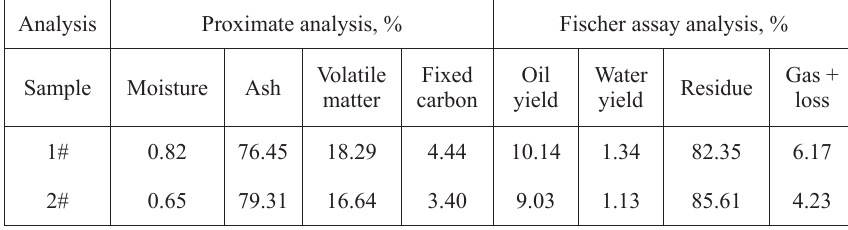
Table 1. Proximate and Fischer assay analyses of oil shale Analysis Proximate analysis, % Fischer assay analysis, % Volatile Sample Moisture Ash